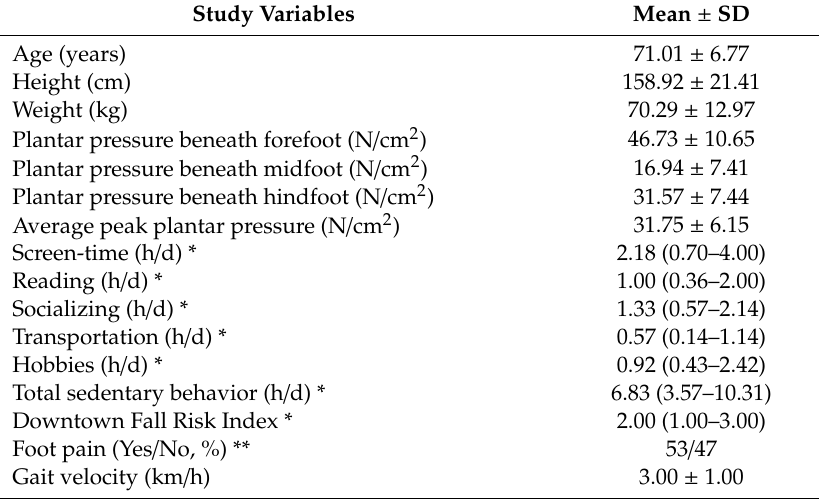
Table 1. Basic descriptive statistics of the study participants ( n = 120).